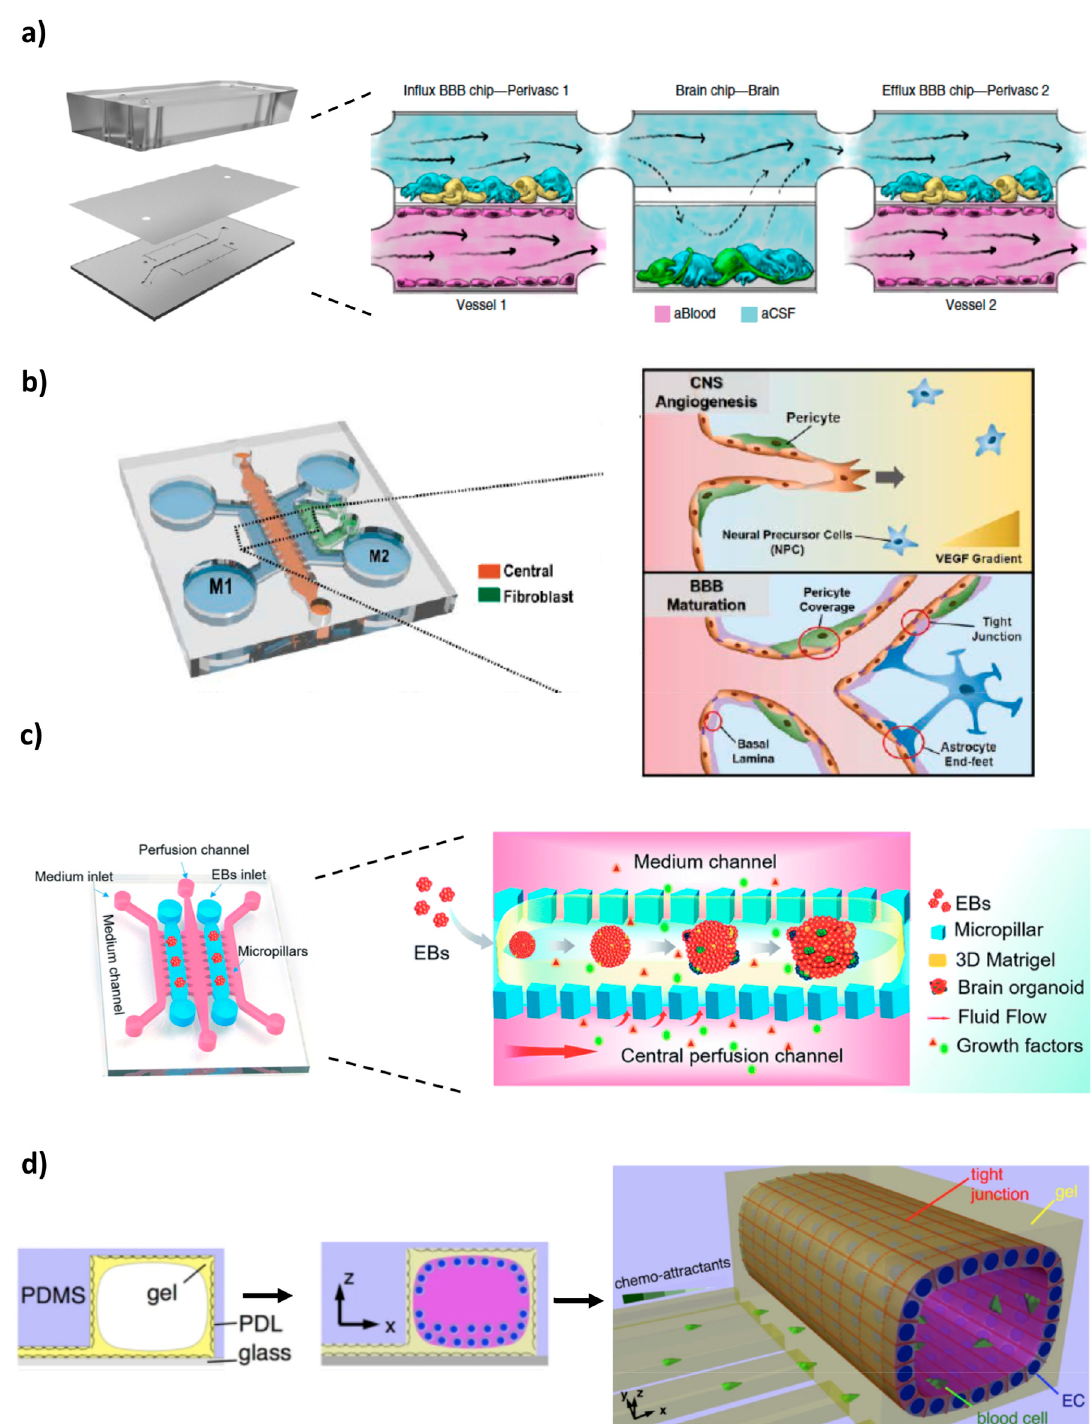
Figure 4. Examples of 3D BBB microfluidic models: ( a ) three interconnected systems—one brain chip between two BBB chips—to obtain insights into previously unknown metabolic interactions between the different cells of the NVU, ( b ) 3D brain angiogenesis model for reconstitution of BBB efflux transporter system (P-gp) under perfusion conditions, ( c ) brain organoid-on-a-chip that recapitulates the early human brain development, ( d ) microfluidic platform for the study of neurovascular pathology. Reprinted and adapted with permission from: ( a ) Maoz et al. [64] , ( b ) Lee et al. [75] , ( c ) Wang et al. [76] . Published by The Royal Society of Chemistry, ( d ) Cho et al. [78] .